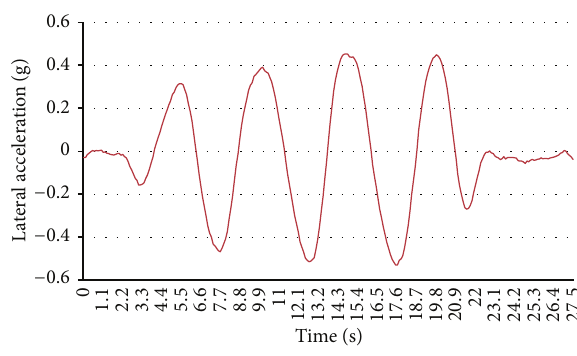
Figure 11: Vehicle’s lateral acceleration with